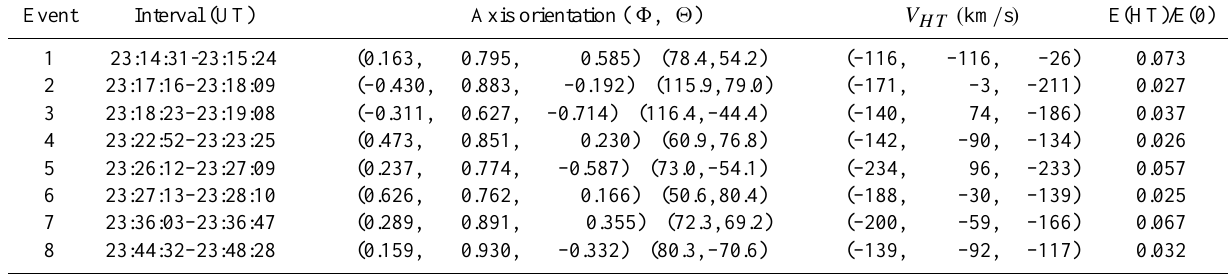
Table 1. The axis orientation and V HT of the flux ropes in the GSM coordinates.